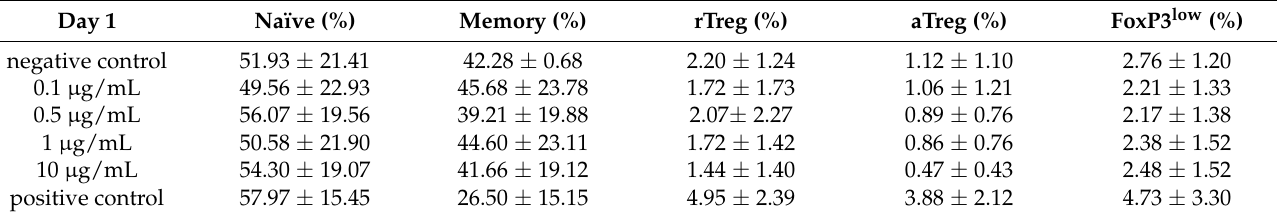
Table 2. Variation in CD4 + subpopulations after incubation with ZnO-NP in different concentrations for 24 h. None of the NP concentrations caused a statistically significant alteration compared to the negative control. Data represent the mean +/ − standard deviation (n = 9).